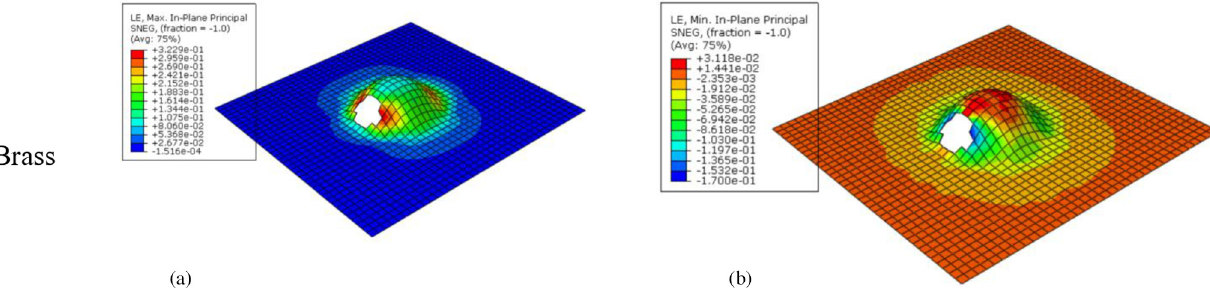
Fig. 6. (a) Maximum in-plane principle strain under biaxial stretching. (b) Minimum in-plane principle strain under biaxial stretching.